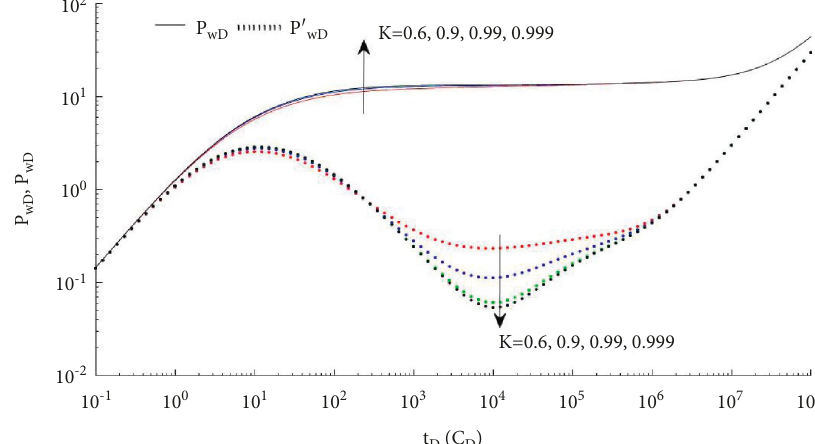
Figure 8: Dimensionless pressure of vertical wells under the constant boundary influenced by K ( C